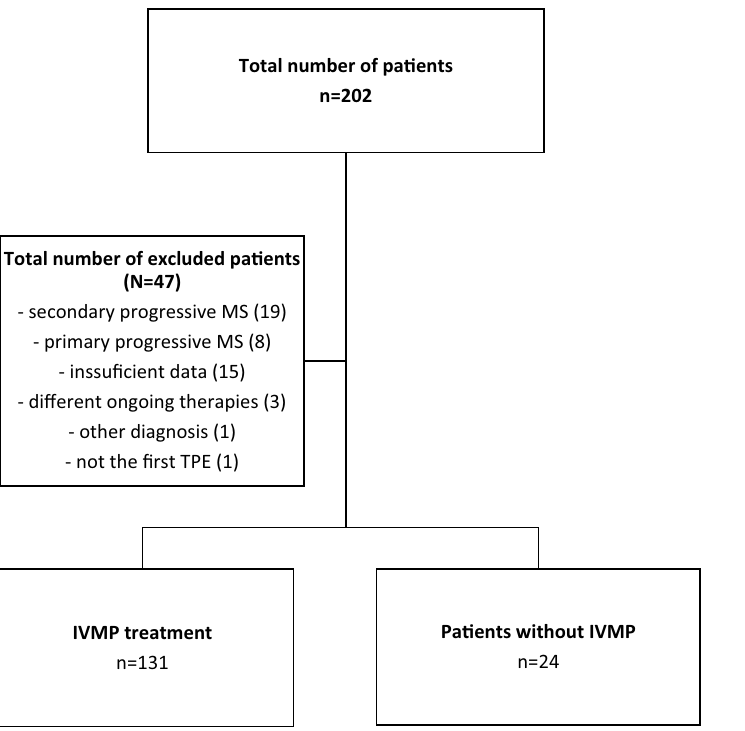
Figure 1. Study flowchart. Legend: MS—multiple sclerosis, TPE—therapeutic plasma exchange, IVMP— methylprednisolone intravenous